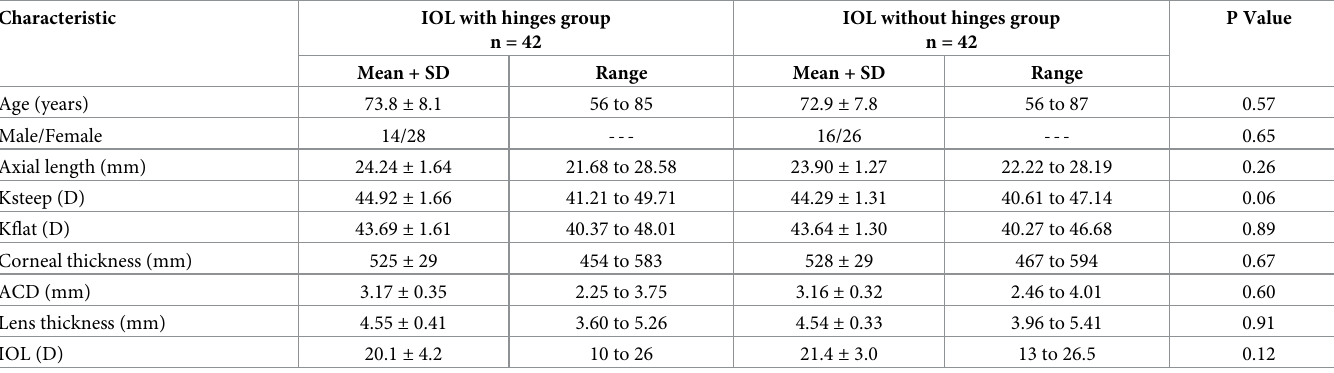
Table 1. Demographic data and preoperative optical properties of the eyes.